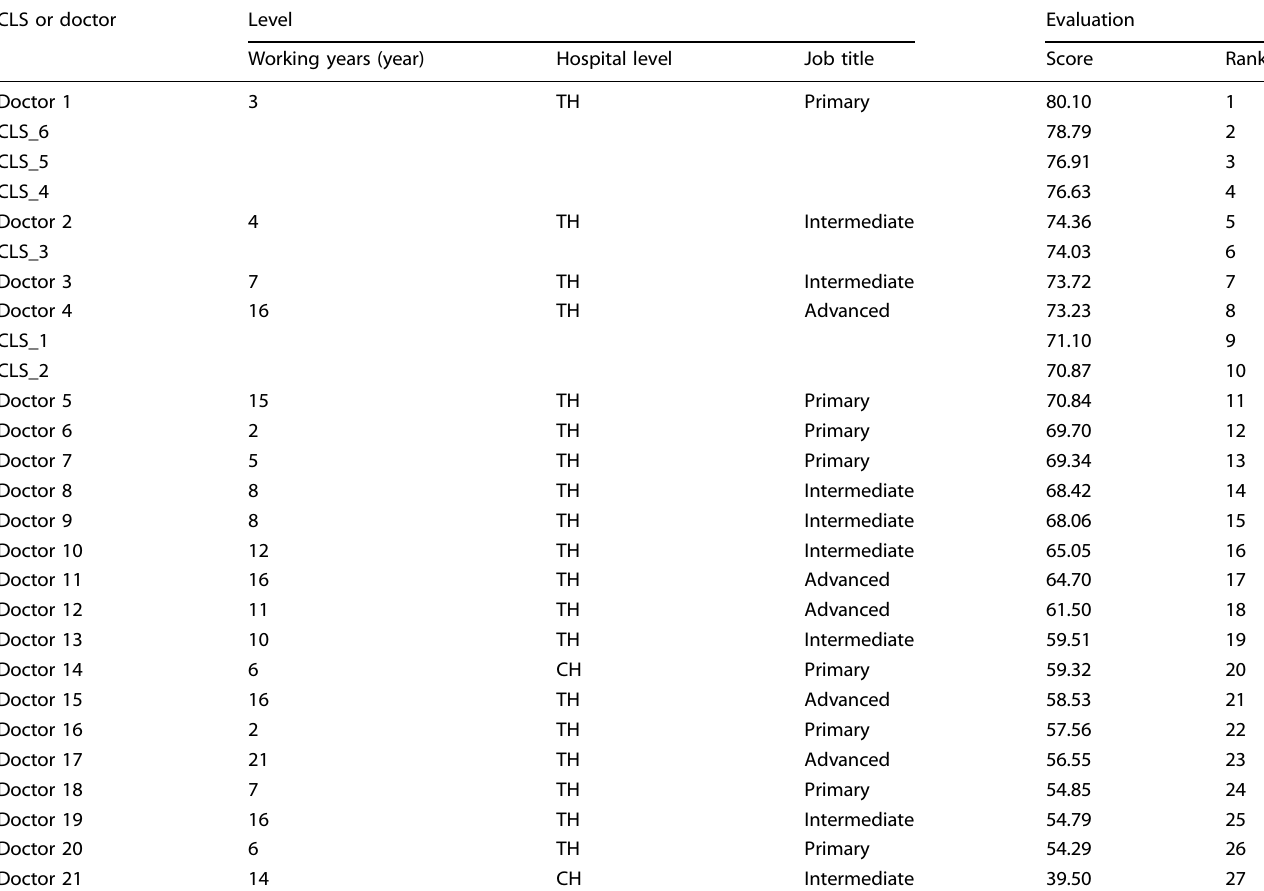
Table 4. The total score ranking of participating physicians and CLS comparison